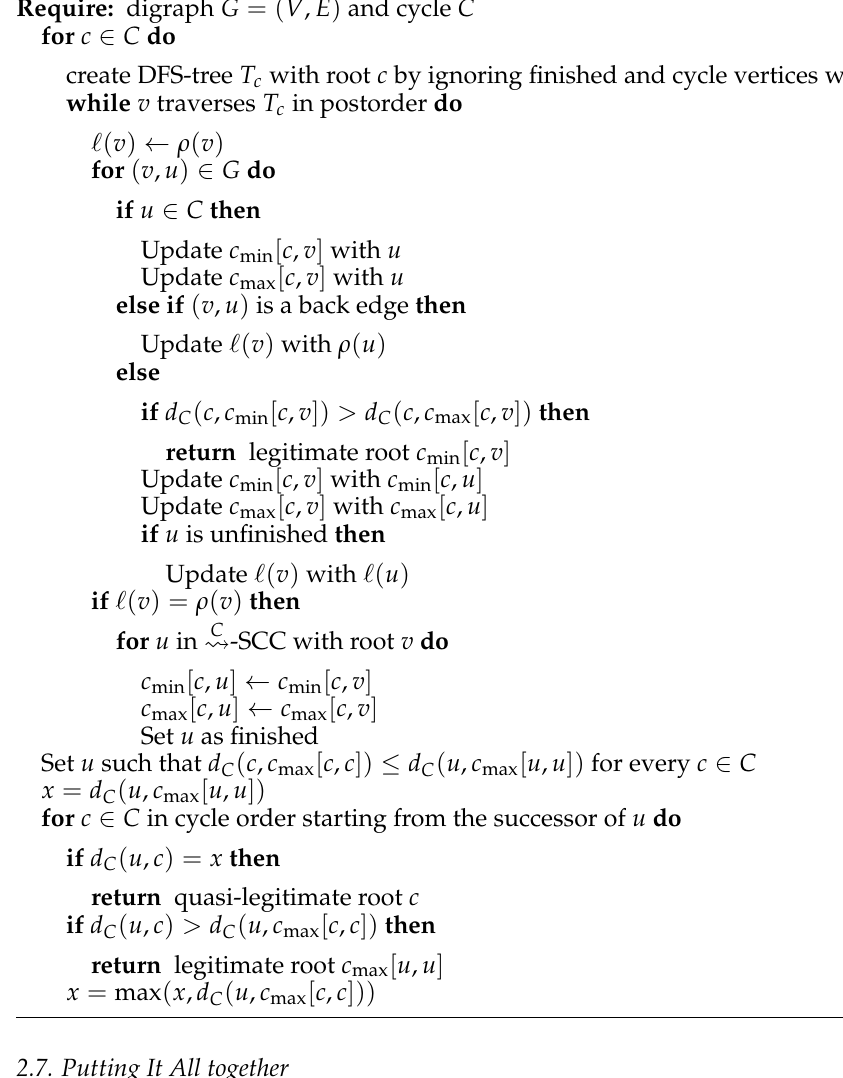
Algorithm 1 get _ root ( C , G ) computes a C (cid:32) -cover and determines Q ( C ) , as well as a quasi-legitimate root in C